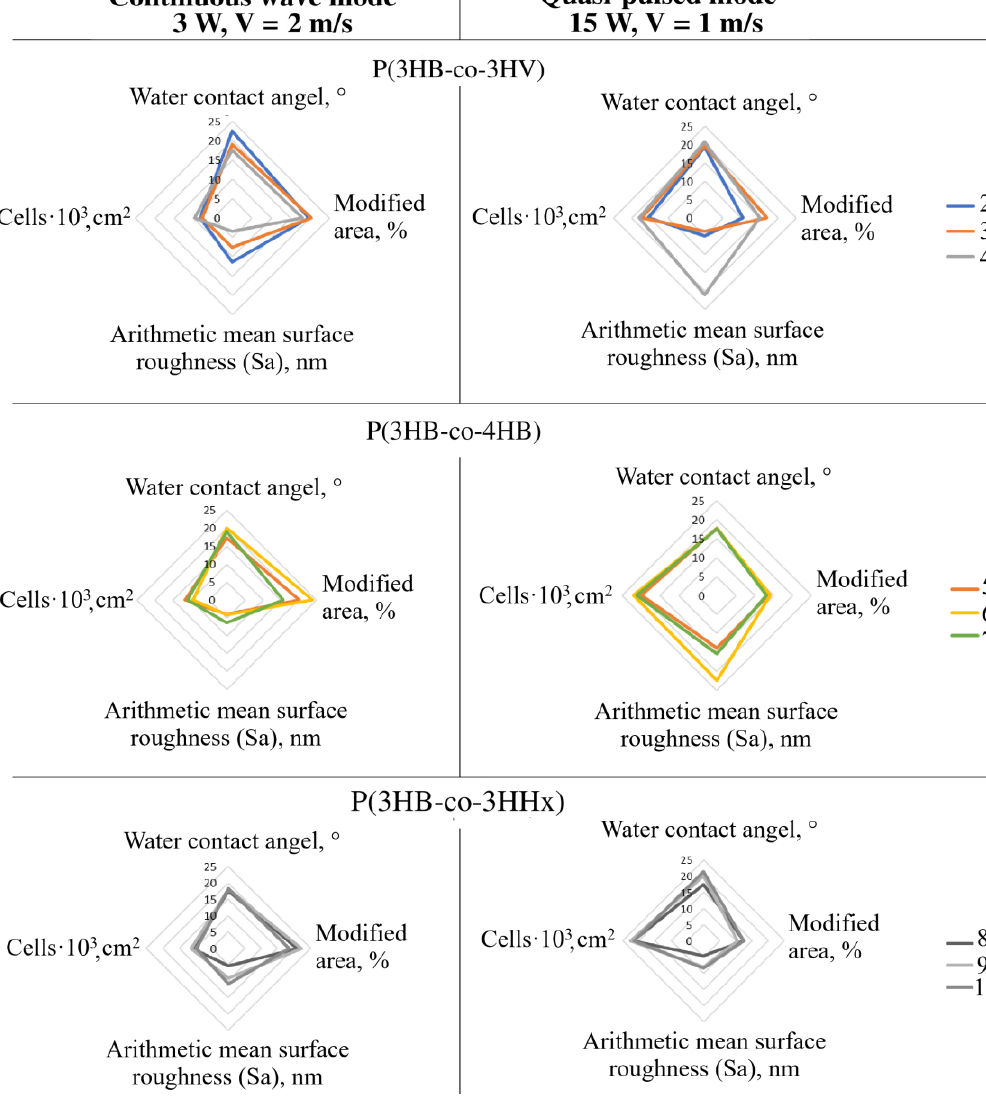
Figure 8. Radar chart representation of the characteristic values of PHAs films processed in 2 laser irradiation modes, (numbering—Table 1): 2–4—P(3HB-co-3HV); 5–7—P(3HB-co-4HB);